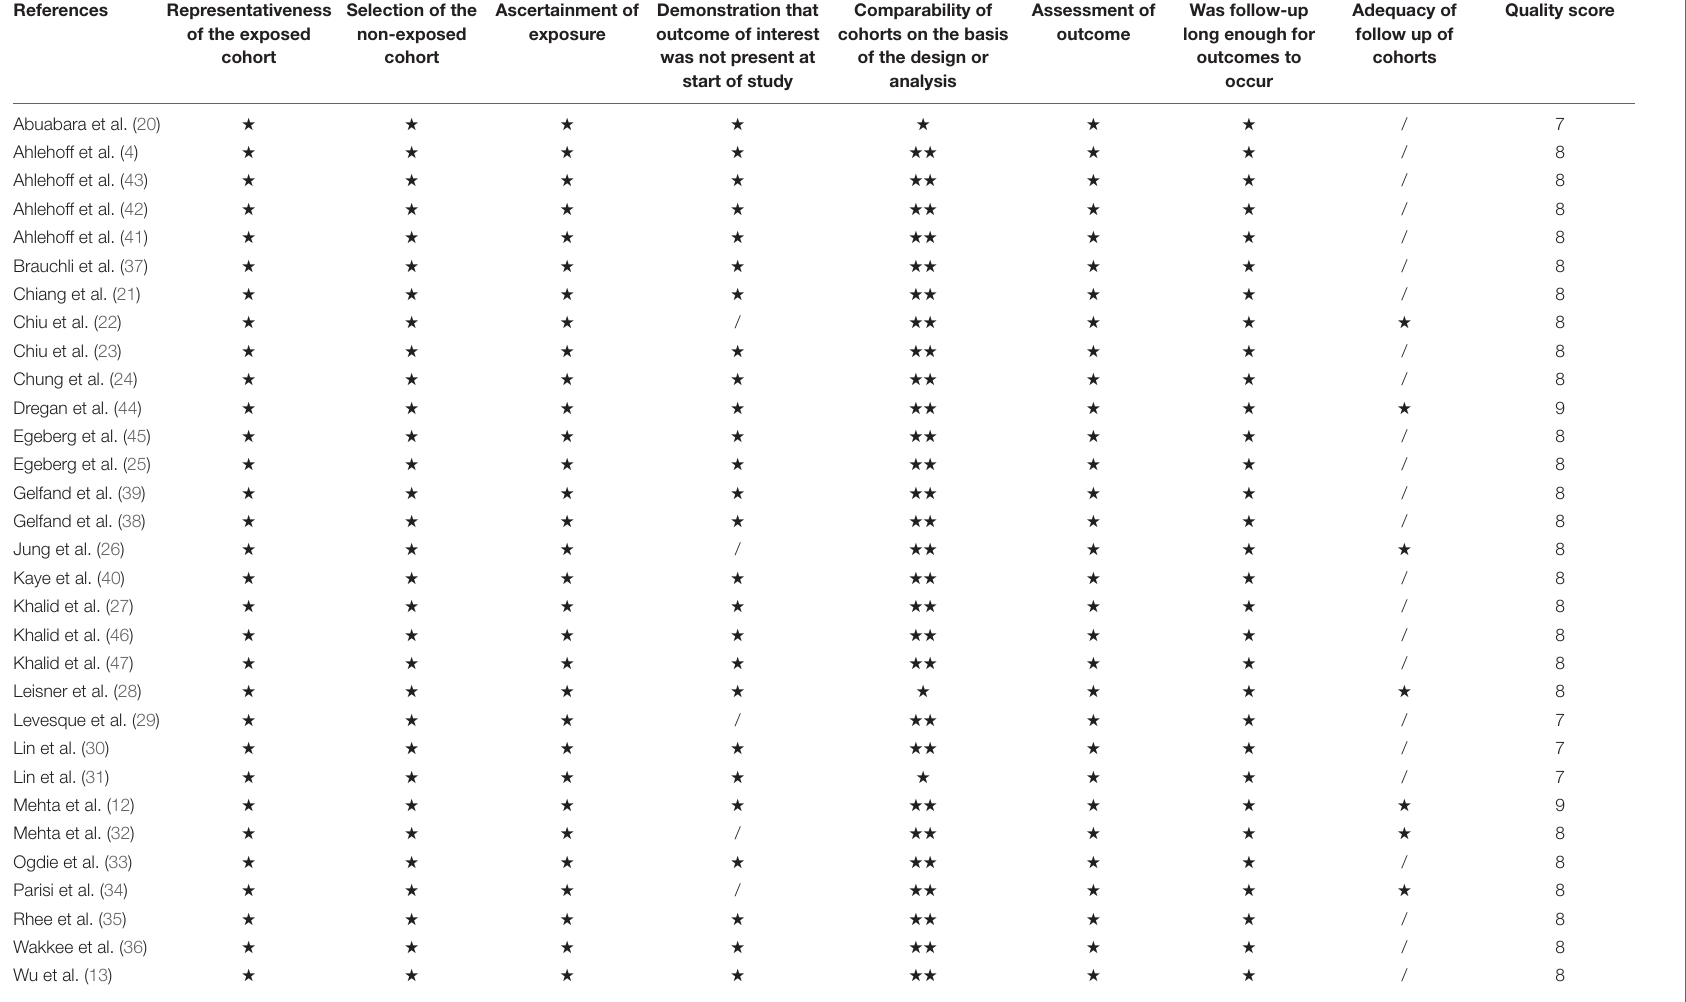
TABLE 2 | The quality assessment of 31 included studies based on the Newcastle–Ottawa Scale (range